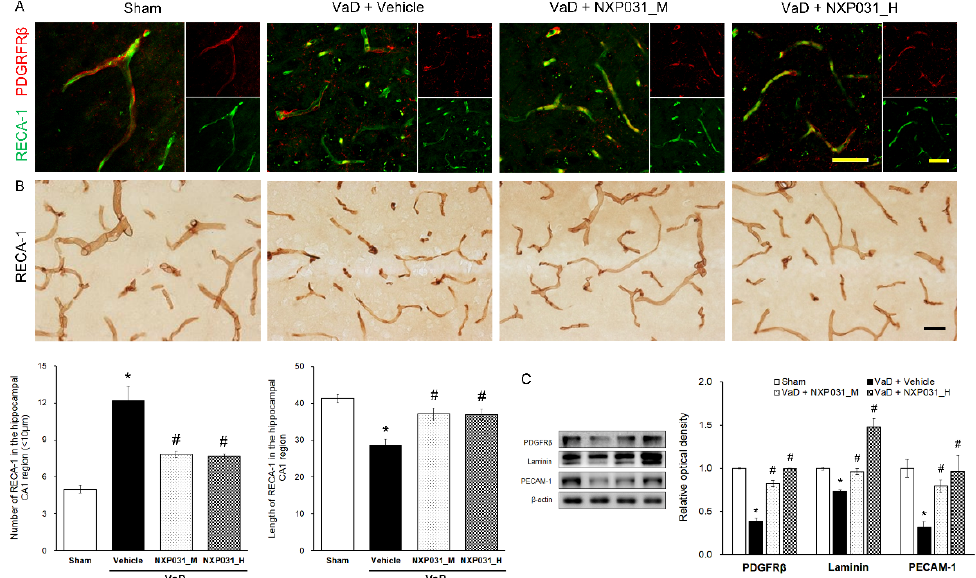
Figure 3. Effect of NXP031 on CCH-induced microvessels damage and BBB disruption in the hip- pocampus. ( A ) Representative photographs of immunofluorescence staining of PDGFR β (red) and RECA-1 (green) in the hippocampal CA1 region after CCH. ( B ) Representative photographs of im- munostaining of RECA-1 in the hippocampal CA1 region after CCH. NXP031 reduced the number of microvessels < 10 μ m in the hippocampus. ( C ) Representative bands of PDGFR β , Laminin, PECAM-1 protein expression in the hippocampus after CCH. The data are presented as the mean ± S.E.M. * p < 0.05 compared with the sham group. # p < 0.05, compared with the VaD group. Scale bar: 50 μ m.